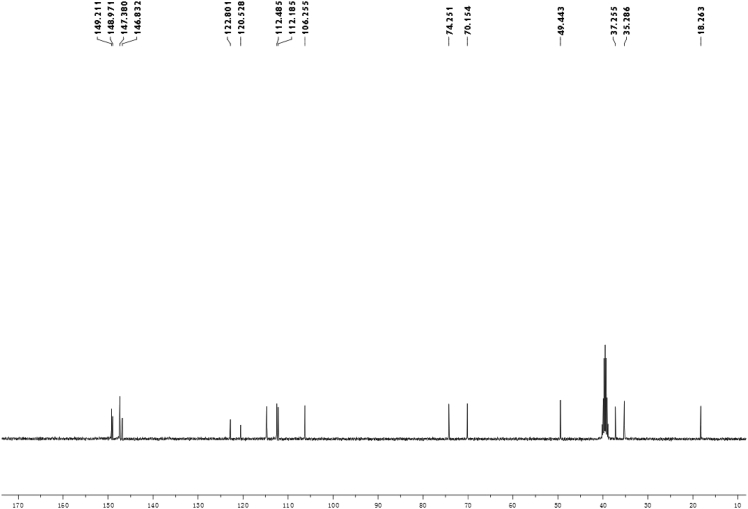
13C-NMR spectrum of meroterpenoid 6.